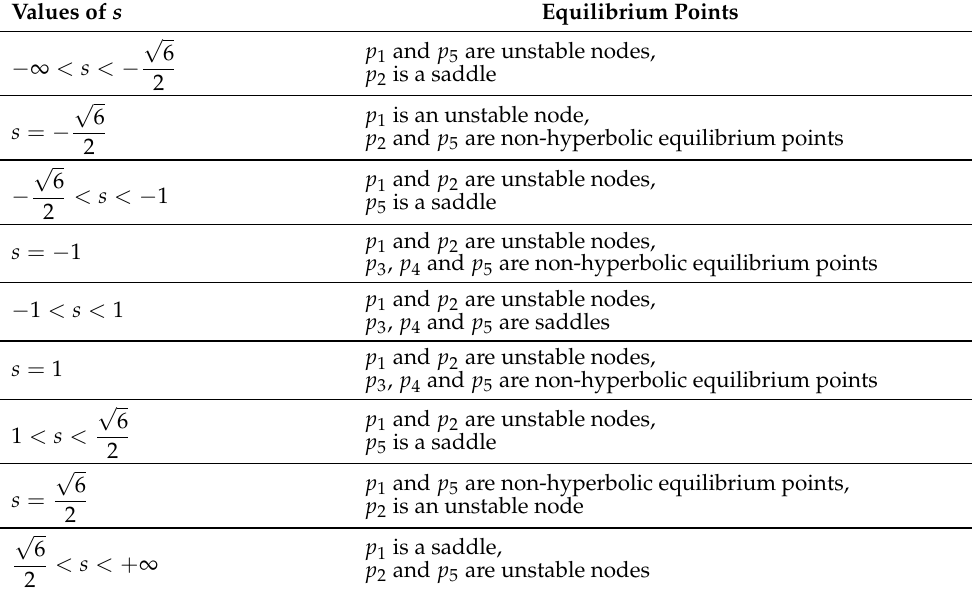
Table 3. Finite equilibrium points for the different values of s , where p 1 = ( 1,0,0 ) , p 2 = ( − 1,0,0 )